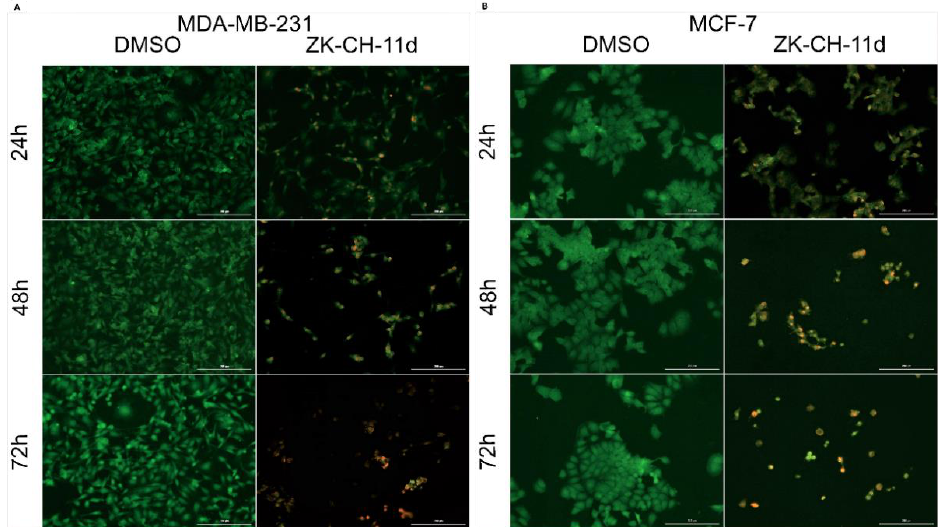
Figure 7. Fluorescence microscopic analysis of apoptosis using Acridine orange/Propidium iodide staining of MDA-MB-231 ( A ) and MCF-7 ( B ) cells after treatment with chalcone ZK-CH-11d at a concentration of 40 μmol/L for 24, 48 , and 72 h of treatment. Green represents live cells, yellow cells are in early apoptosis, orange cells are in late apoptosis, and red represents dead/necrotic cells. The figure is a representative average of three independent experiments. Magnification: 100×.